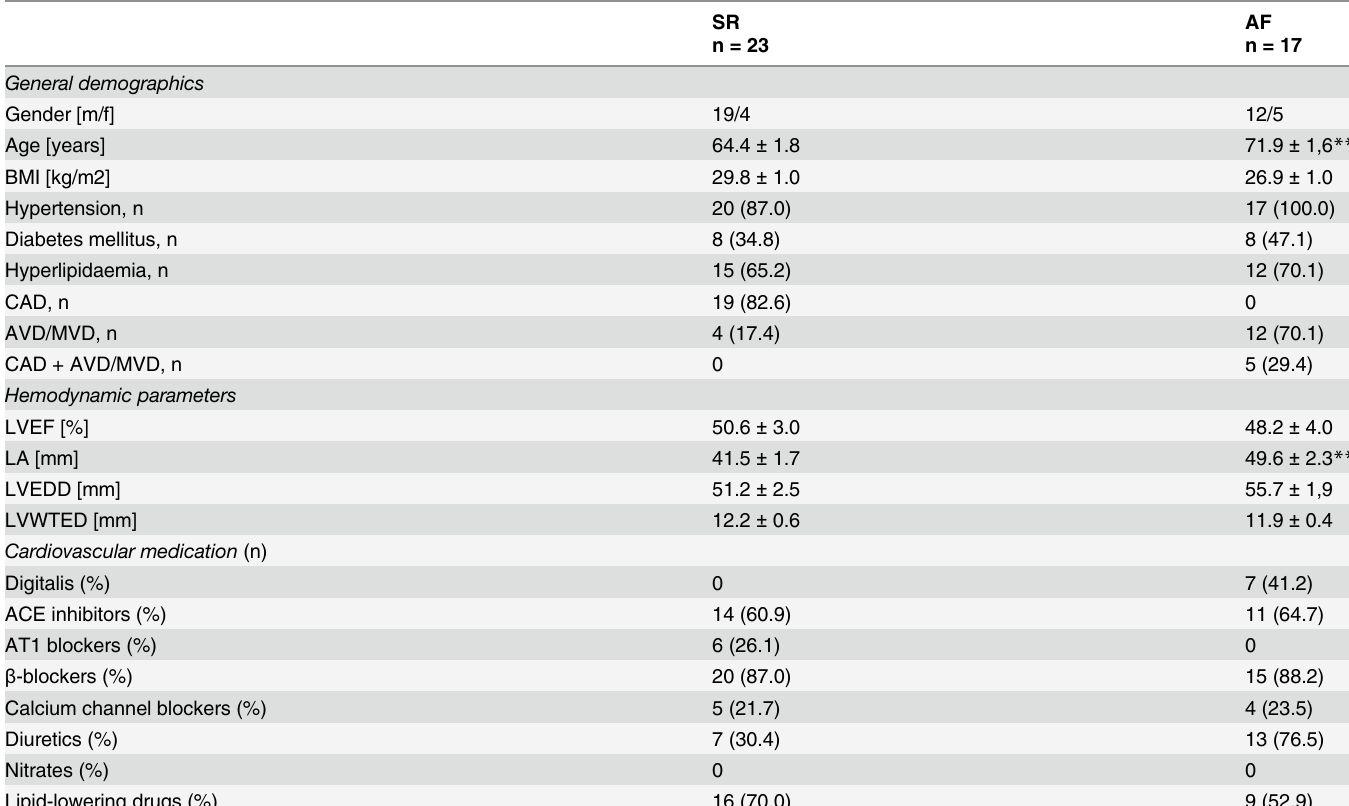
Table 1. Clinical characteristics of patients